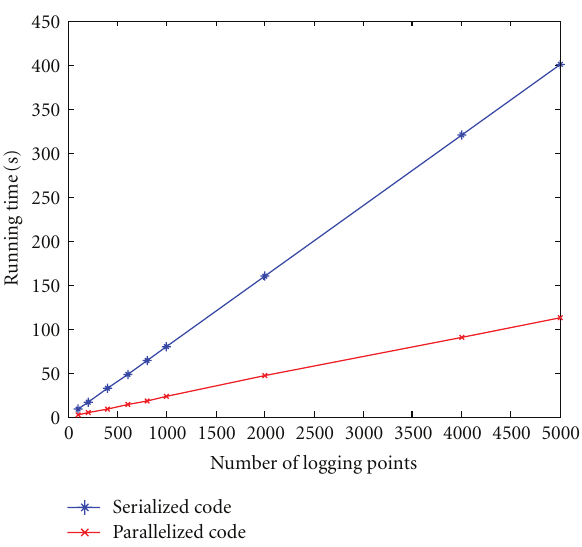
Figure 14: Comparison of the total running time of the serialized model and the parallelized model for the 15-layer Oklahoma